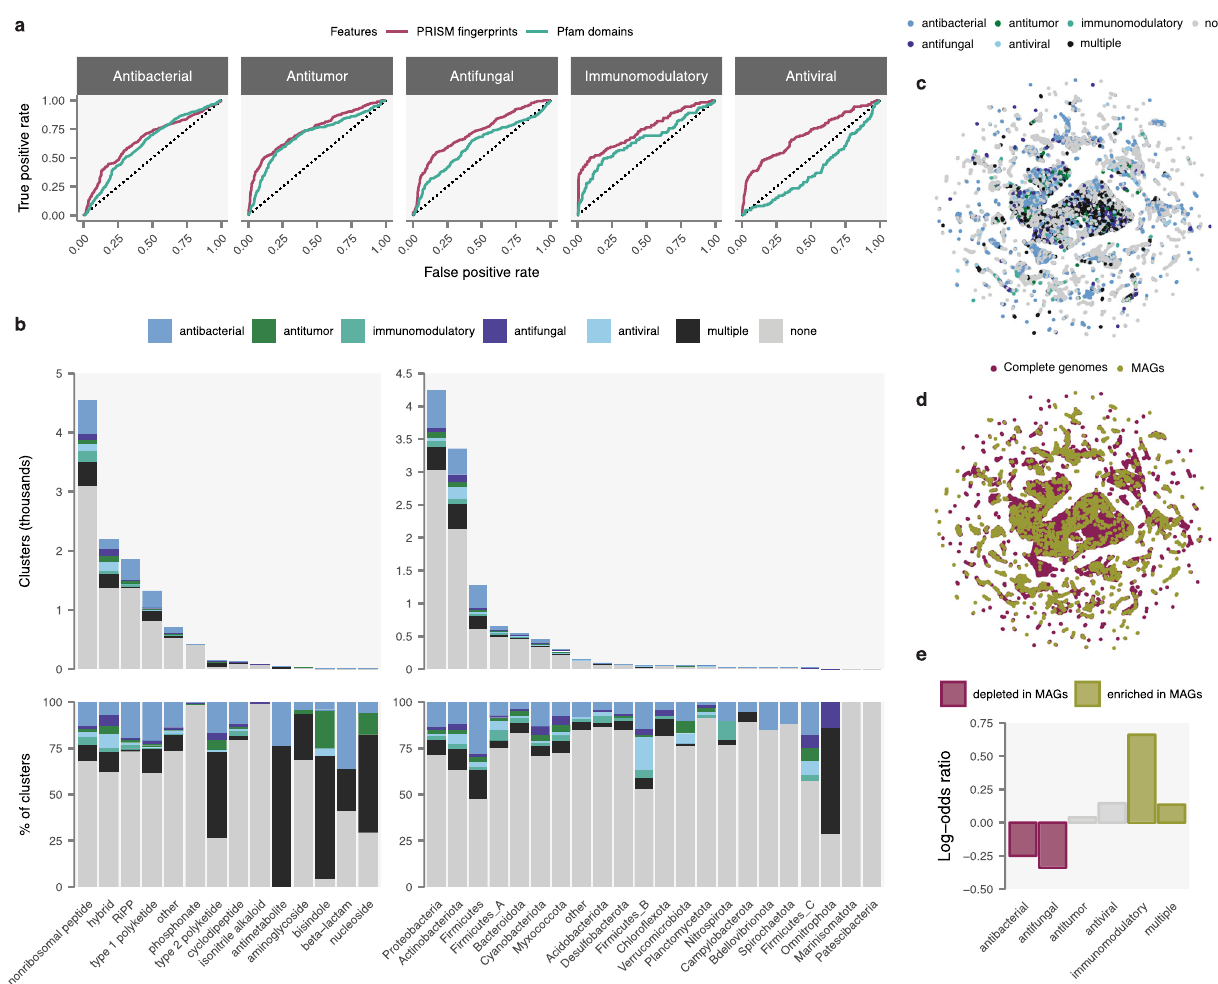
Fig. 4 Quantitative predicted structure-activity relationship (QPSAR) modeling reveals thousands of genomically encoded antibiotics. a Receiver operating characteristic (ROC) curves for support vector machine (SVM) models trained on Pfam domains found within biosynthetic gene clusters or chemical fi ngerprints of PRISM predicted structures. b Distribution of BGCs predicted to produce secondary metabolites with antibacterial, antitumor, immunomodulatory, antifungal, antiviral, multiple, or no biological activities in a collection of 10,121 complete or metagenome-assembled prokaryotic genomes, by biosynthetic family (left) or producing organism phylum (right), as classi fi ed in the Genome Taxonomy Database (GTDB) 15 . c , d Visualization of predicted structure chemical space by uniform manifold approximation and projection (UMAP) 25 , colored by biological activity ( c ) or genome origin ( d ). e Enrichment or depletion of secondary metabolites by predicted biological activity in metagenome-assembled genomes (MAGs), relative to complete bacterial genomes. Source data are provided as a Source Data fi